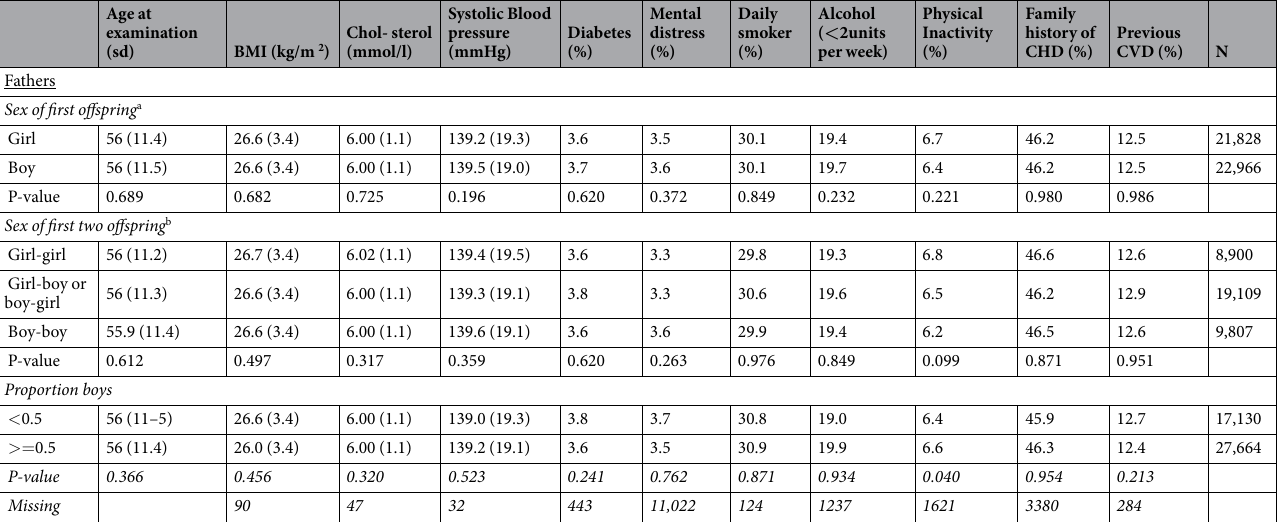
Table 6. Mean values and standard deviations with test of differences (linear or logistic regression) of some risk factors among fathers in a linked sub cohort being part of the Cohort of Norway (CONOR) according to sex of first offspring, sex of first two offspring and proportion boys. a These 44,794 fathers from the full cohort were identified as participating in CONOR with at least one offspring. b These 38,816 fathers from the full cohort were identified as participating in CONOR with at least two